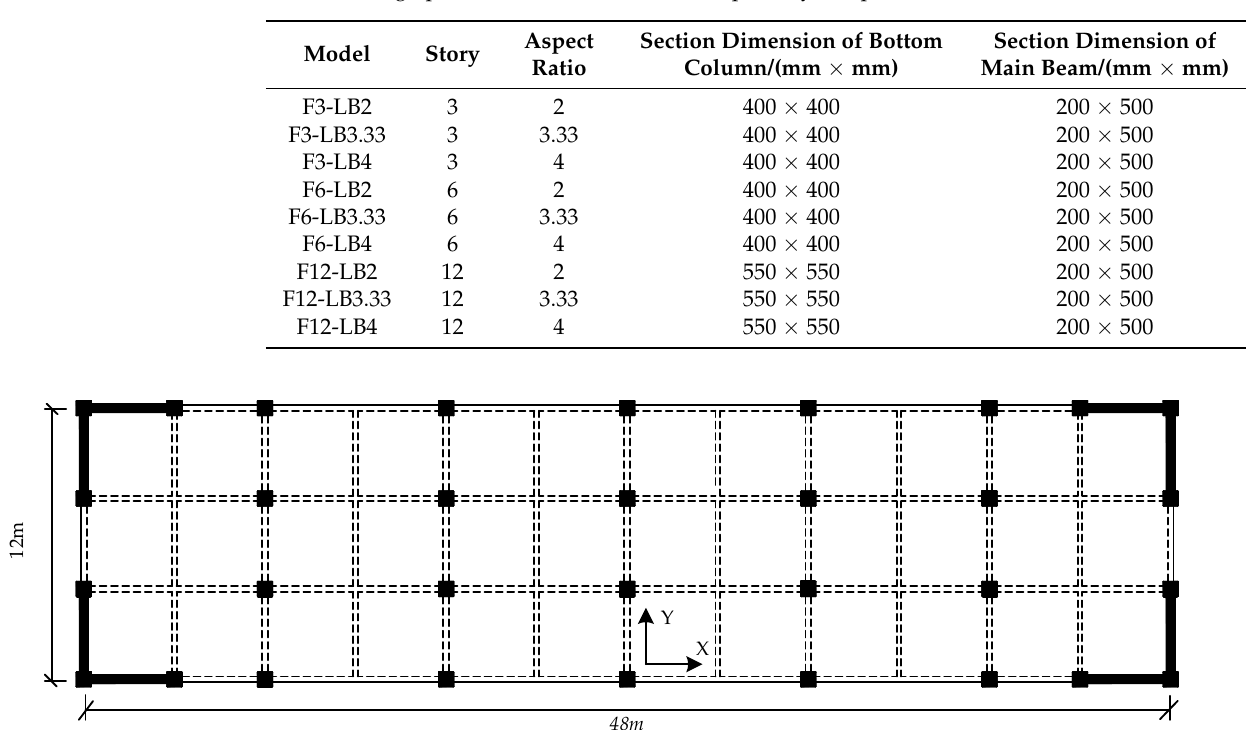
Table 1. Design parameters and dimensions of primary components.